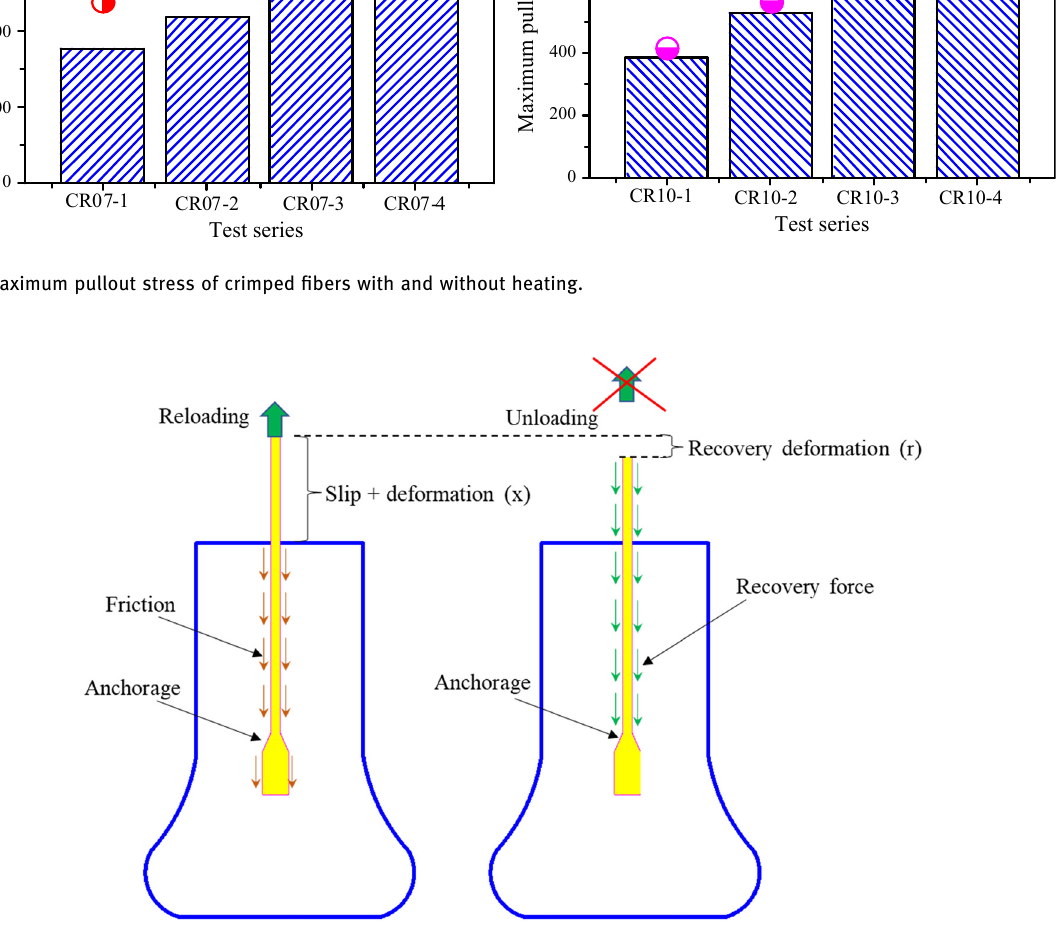
Figure 8: Recovery deformation mechanism of the fi ber at each cycle